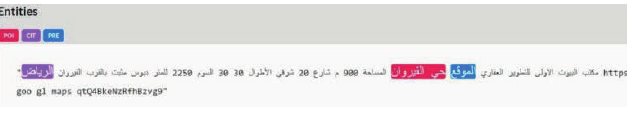
Fig. 2. Sample of labelled textual data from AQAR dataset.